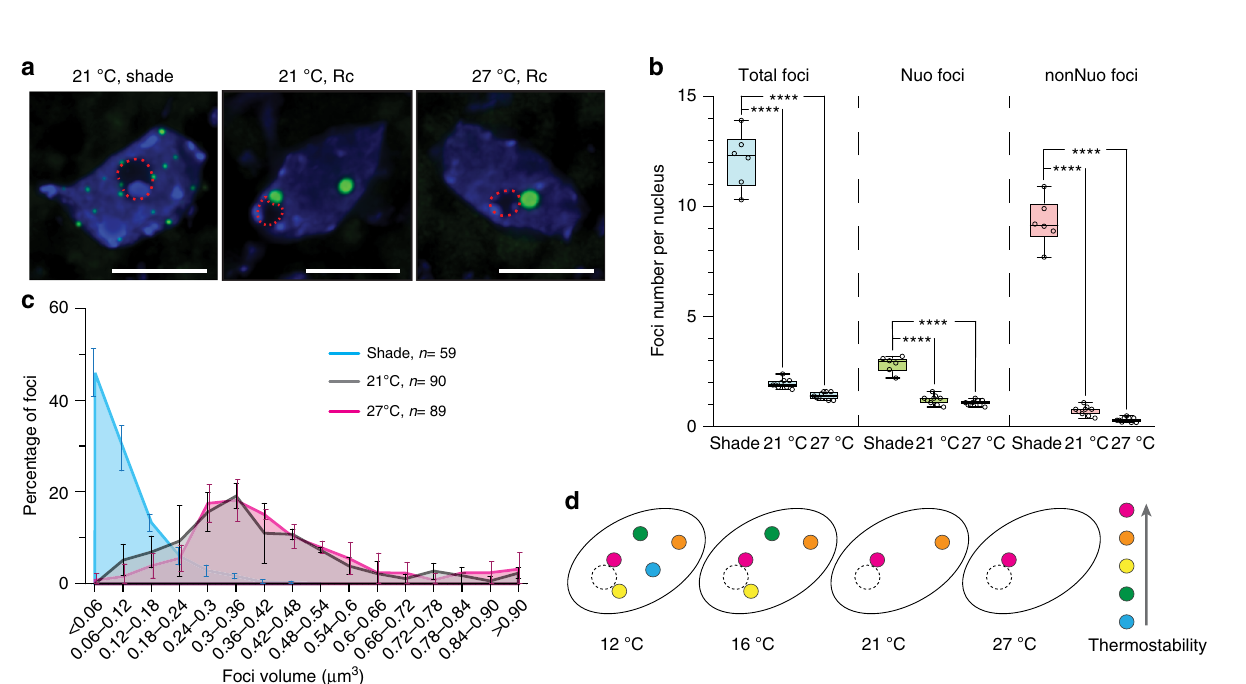
Fig. 5 BCY and YHB-YFP display distinct temperature-insensitive PB patterns. a Maximum-projection, deconvolved images showing representative steady-state patterns of phyB C-terminal module fused with YFP (BCY) or YHB-YFP PBs in cotyledon epidermal-cell nuclei of 4-day-old BCY and YHB seedlings, respectively, grown at 12, 16, 21, and 27 °C in the dark or in 10 µ mol m − 2 s − 1 in R light. Nuclei were labeled by DAPI (blue), white arrowheads indicate Nuo-PB, and the boundaries of the nucleoli are traced by red dashed lines. The percentage of nuclei with s.e. showing the representative PB pattern is shown in each image; n indicates the total number of nuclei analyzed. Scale bars represent 5 μ m. b , c Quanti fi cation of the numbers of total, Nuo, and nonNuo PBs per nucleus in cotyledon epidermal-cell nuclei of the BCY ( b ) and YHB ( c ) seedlings described in a . d Quanti fi cation of the percentage of nuclei with the indicated number of PBs in cotyledon epidermal-cell nuclei of the BCY and YHB seedlings described in a . Error bars represent s.e. calculated from groups of seedlings. Different letters denote statistically signi fi cant differences (ANOVA, Tukey ’ s HSD, P ≤ 0.05, n = 3). e Cotyledon size measurements of the BCY or YHB seedlings described in a . f Immunoblot results showing the levels of BCY or YHB-YFP in 4-day-old BCY or YHB seedlings grown in the dark or 10 µ mol m − 2 s − 1 R light in the indicated temperatures. BCY and YHB-YFP were detected by anti-phyB antibodies. RPN6 was used as a loading control. The relative levels of BCY and YHB-YFP normalized against the corresponding levels of RPN6 are shown. g Quanti fi cation of the volume of BCY and YHB- YFP PBs in cotyledon epidermal-cell nuclei of the BCY and YHB seedlings described in a . For b , c , e , g , the boxes represent from the 25th to the 75th percentile and the bars equal the median values. Samples with different letters exhibit statistically signi fi cant differences (ANOVA, Tukey ’ s HSD, P ≤ 0.05, for b , c , and g , n ≥ 9, for e , n ≥ 78). The source data underlying the PB measurements in b – d , g , cotyledon measurements in e , and immunoblots in f are provided in the Source Data fi le.